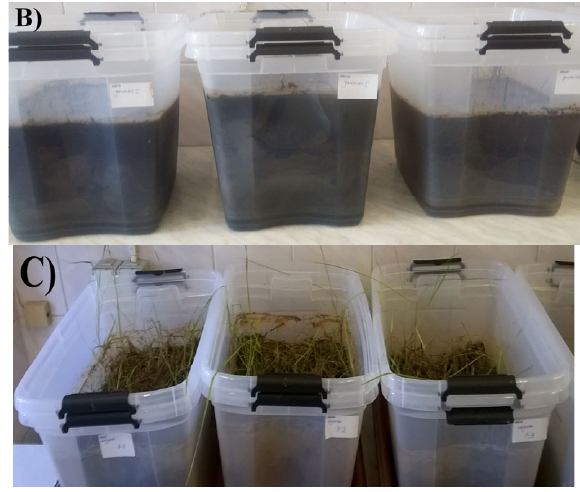
Figure 2. ( A ) Experiment scheme; ( B ) containers with flooded soil (7 days of flooding); ( C ) containers with drained soil (56 days after the floods ended) (author’s materials).